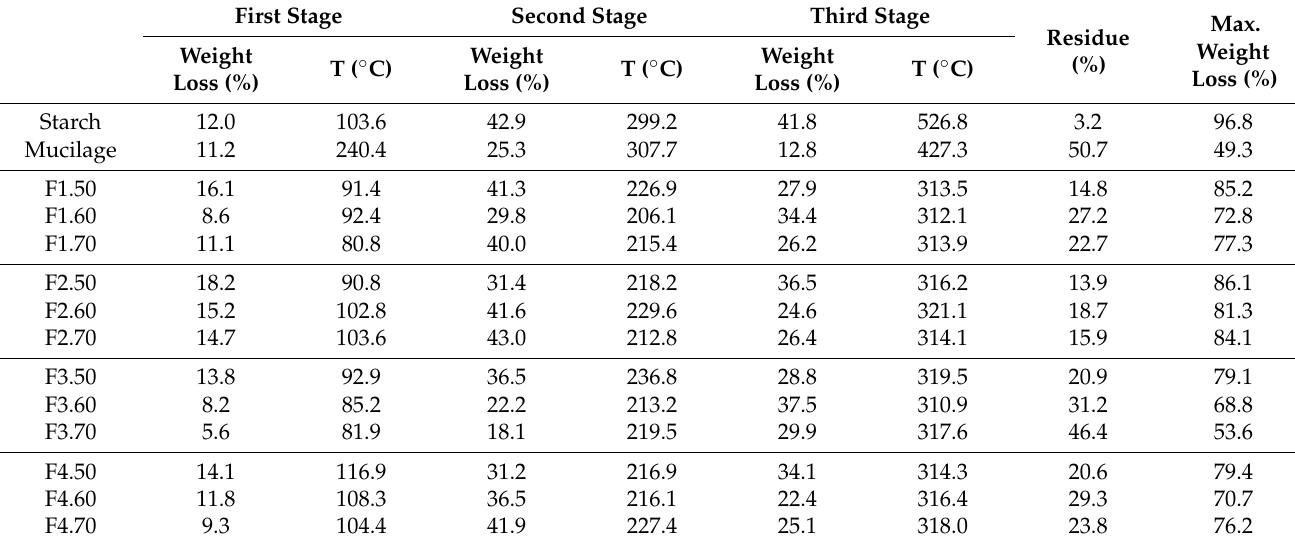
Table 6. Weight loss and decomposition temperature, determined by TGA—DTA.